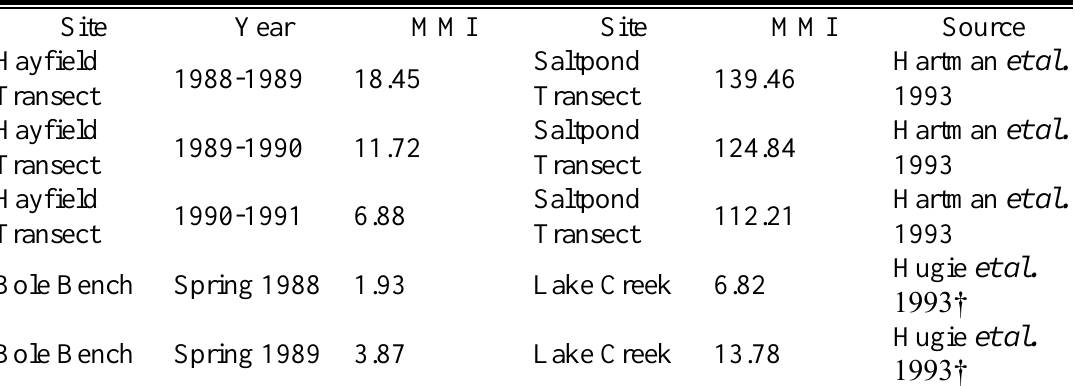
Table A2.2. Yearly and site variation of MMI (No. of dead birds/km of transmission lines/year) values for studies that sampled at least two sites over a minimum of two years and for which site specific data were available. MMI values for Hartman et al. 1993 were calculated for 375 days (study conducted in California) whereas values for Hugie et al. 1993 were calculated for 275 days (study conducted in Montana).